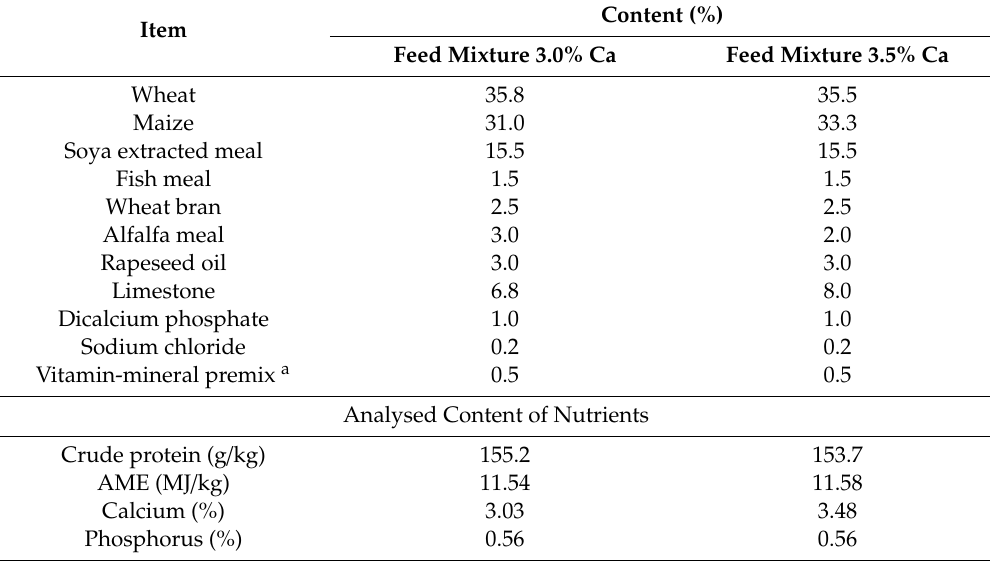
Table 1. Composition of experimental diets and nutrient content on a dry matter